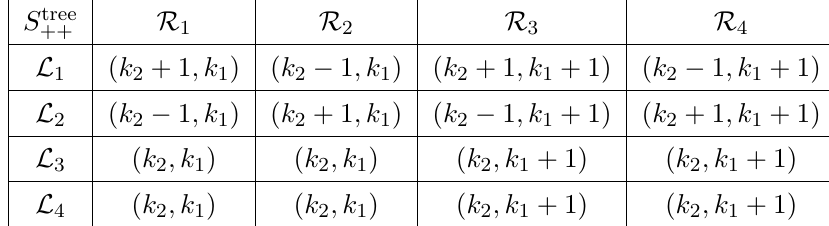
Table 4 . ( k L ; k R ) in all regions for the con(cid:12)guration S ++ .